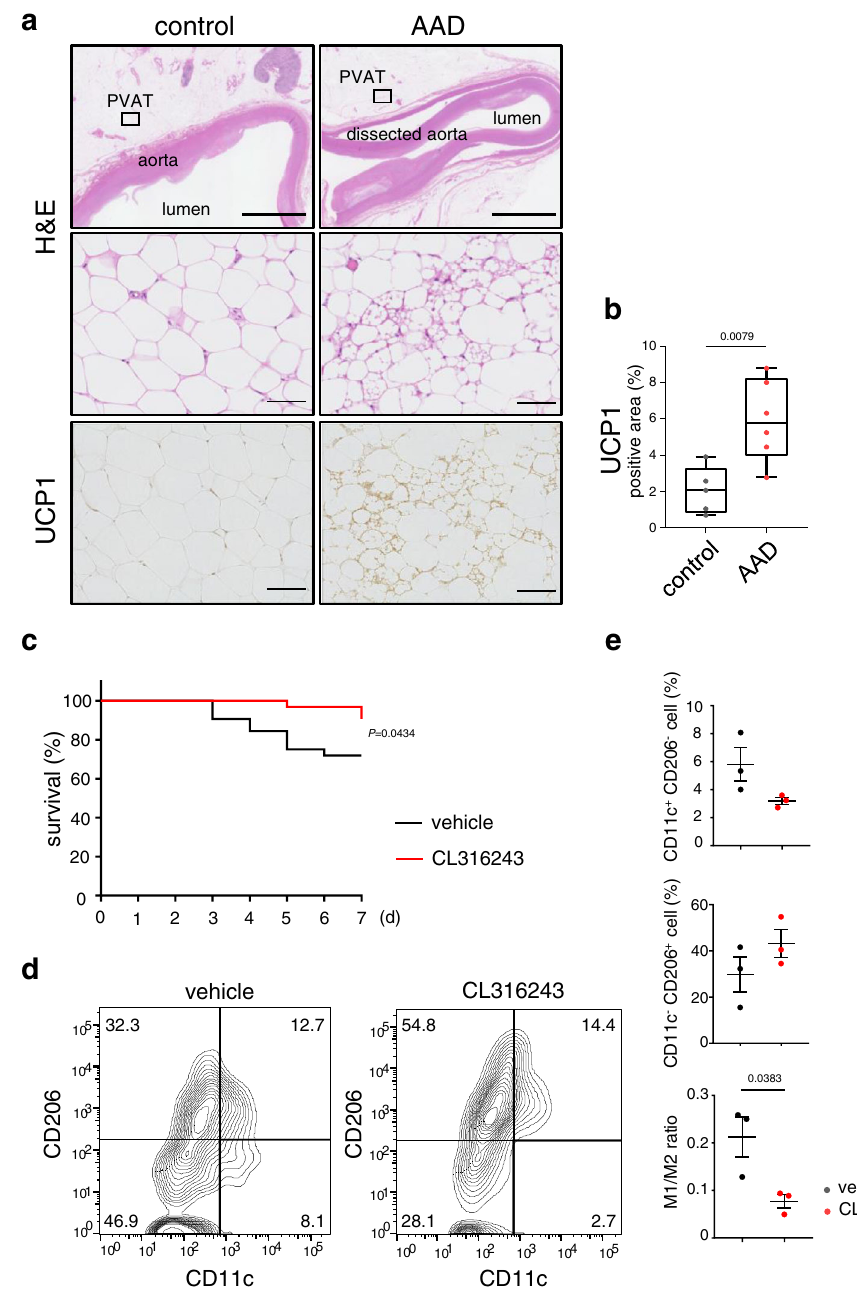
Fig. 5| PVAT beiging in humanand murineaorta with acutedissection.a Aorta tissue samples from patients with or without AAD were collected and H&E and immunohistochemical staining for UCP1 were performed. Scale bars represent 5mm (thick bars) and 100 μ m (thin bars). Images are representative of three independent experiments. b The % of UCP1 + areas in PVAT from patients with or without AAD were analyzed (control, n =5; AAD, n =6, two-sided Mann – Whitney U - test. Box plots denote the median, 25 – 75th percentiles, and minimum and max- imum values). c Survival curves comparing vehicle-treated and CL316243-treated